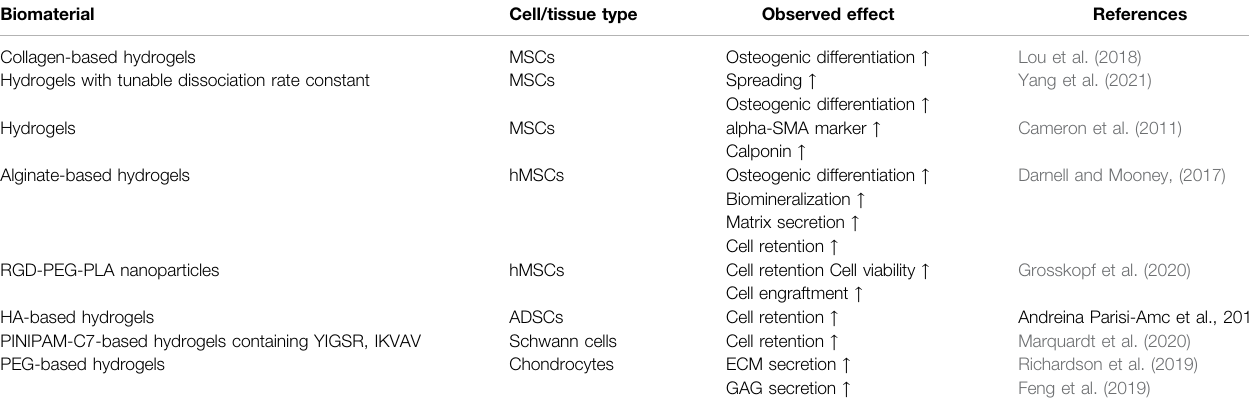
TABLE 3 | Enhancing stem cell function using instructive biomaterials and mechanotransduction.